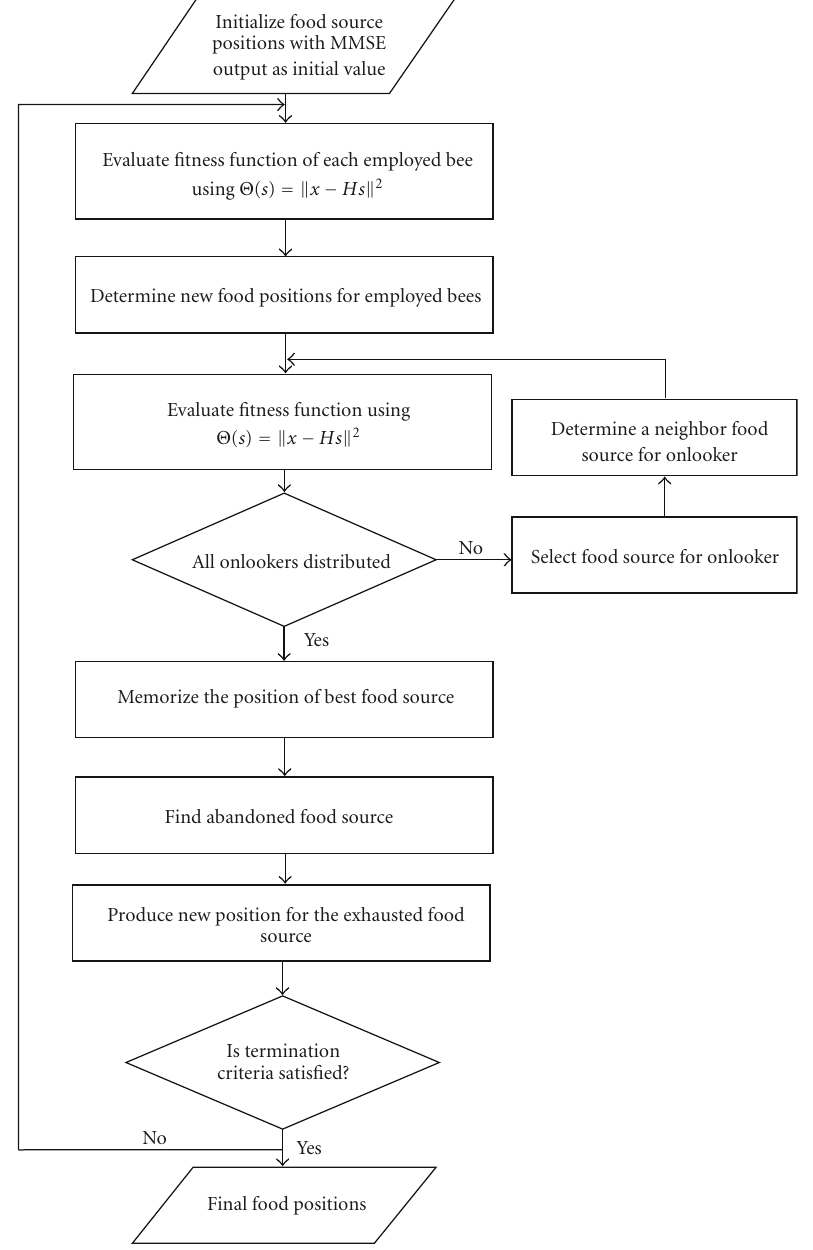
Figure 2: Flowchart of the proposed ABC-MUD